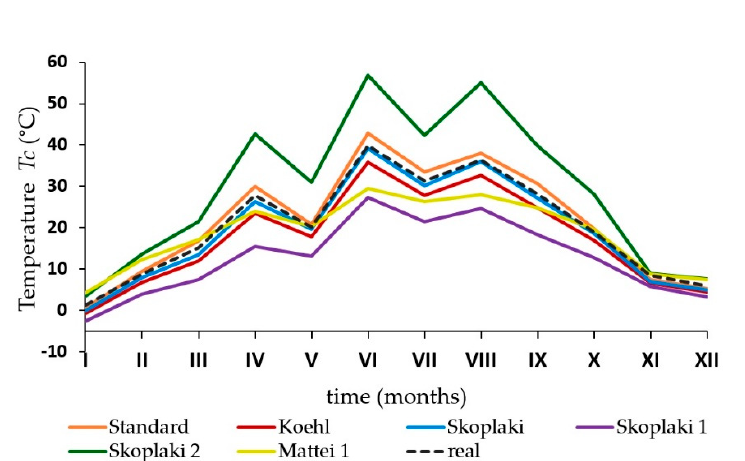
Figure 1. The curves illustrating variability of average monthly temperature values of PV1 array in 2019. They were determined on the basis of mathematical models.